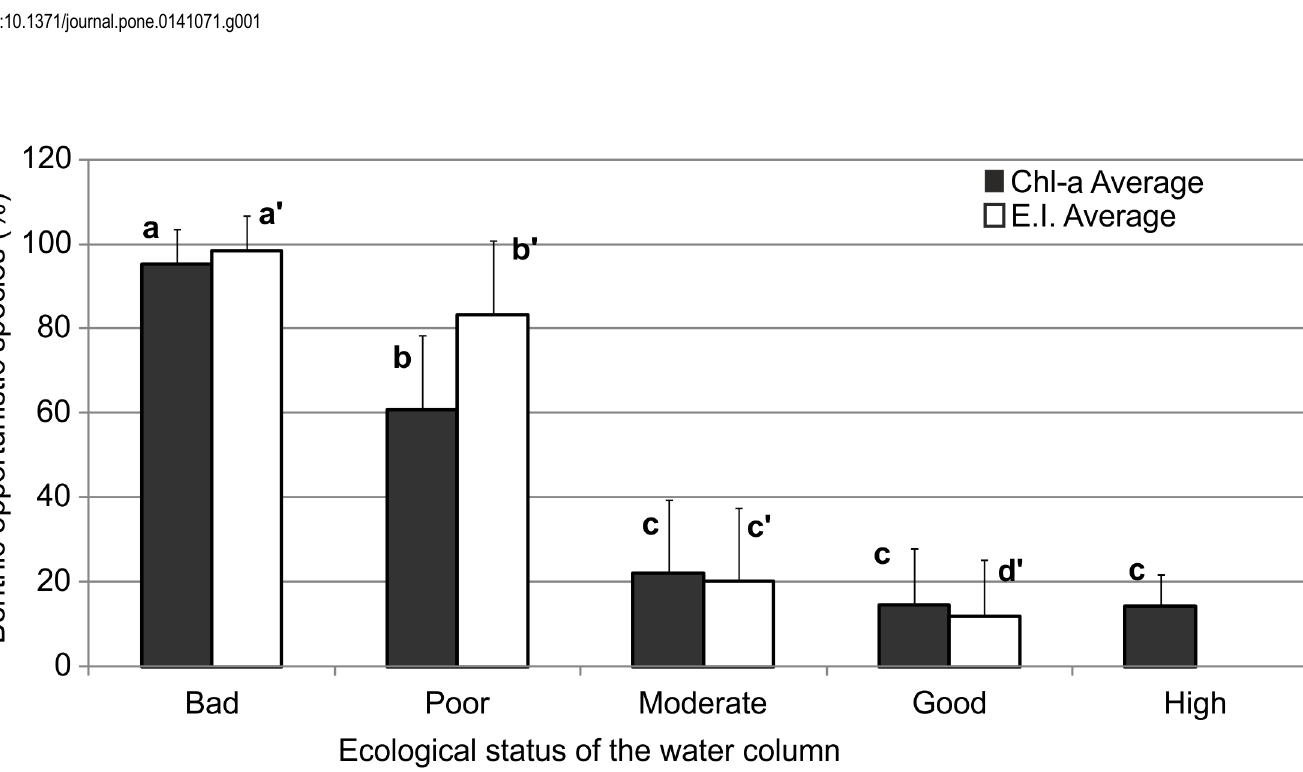
PLOS ONE | DOI:10.1371/journal.pone.0141071 October 23,